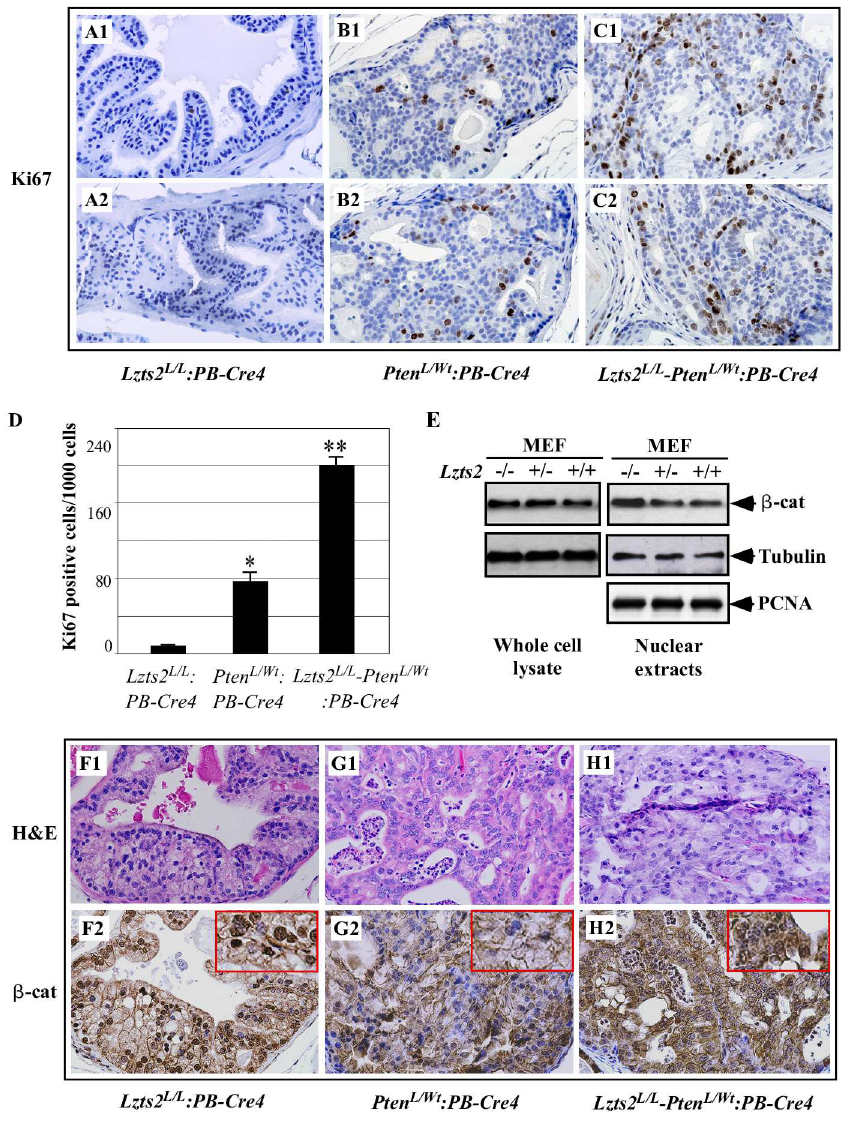
Lzts2 LoxP/LoxP : PB-Cre4 , Pten loxP/Wt : PB-Cre4 , and Lzts2 LoxP/LoxP -Pten loxP/Wt : PB-Cre4 mice were stainedfor Ki-67. (D) A total of 1000 epithelialcells in each lesion from three different lesionsfrom three mice of each genotypewere evaluatedfor Ki-67 immunoreactivity. (E) Mouse embryonicfibroblasts(MEFs) were prepared